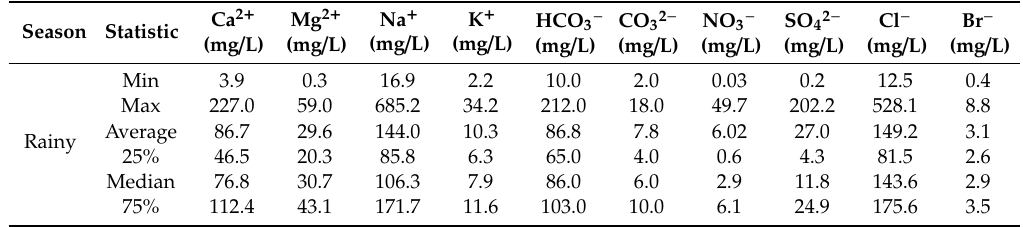
Table 2. Summary of statistic of concentrations of dissolved components measured in 60 groundwater samples.